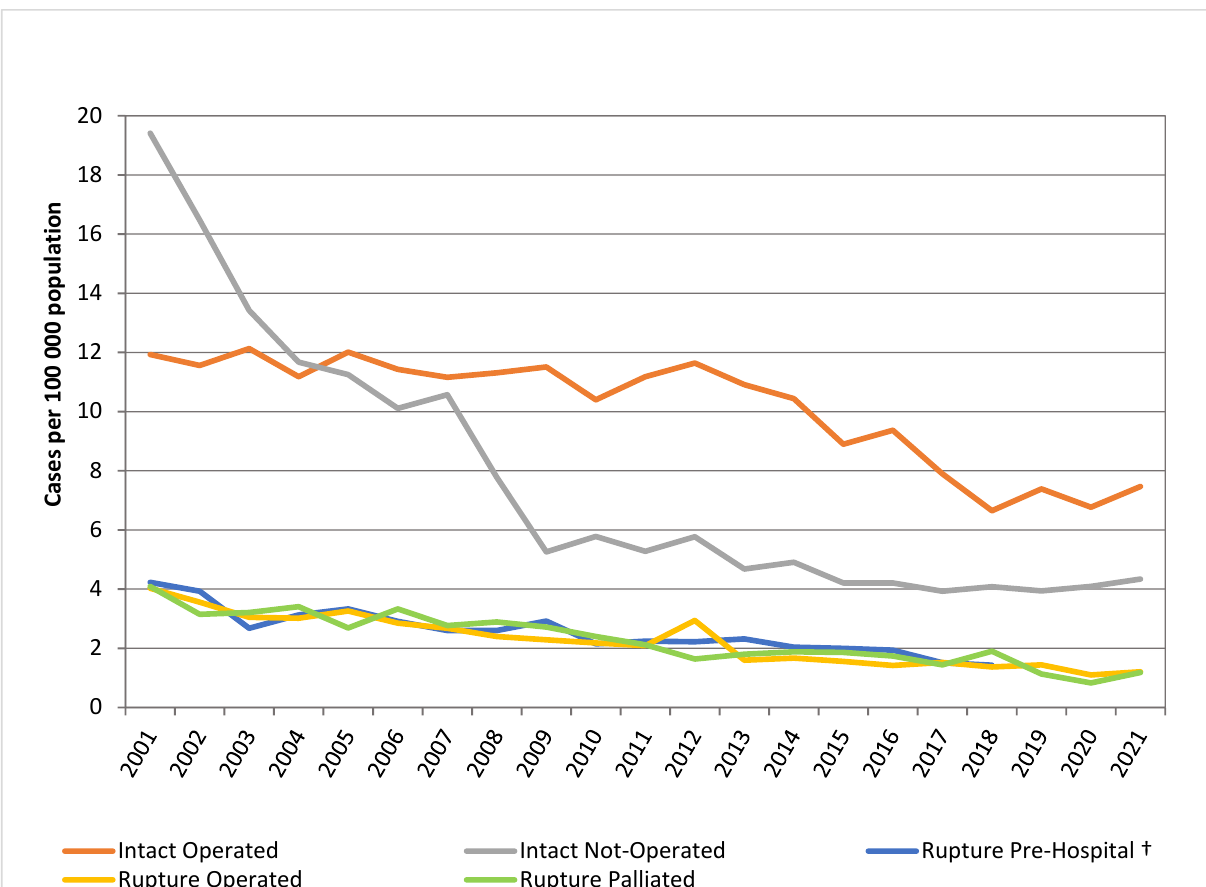
Figure 2. AAA hospitalisation age standardized to NZ population changes.